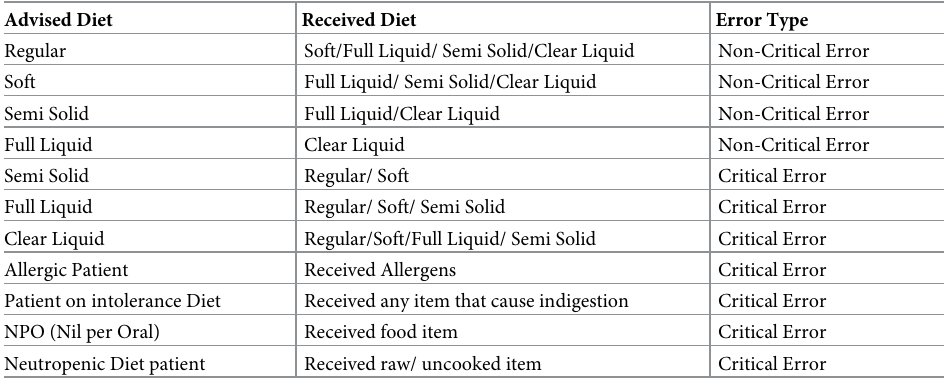
Table 1. Classification of dietary errors as per hospital’s criteria before the consumption of meals.